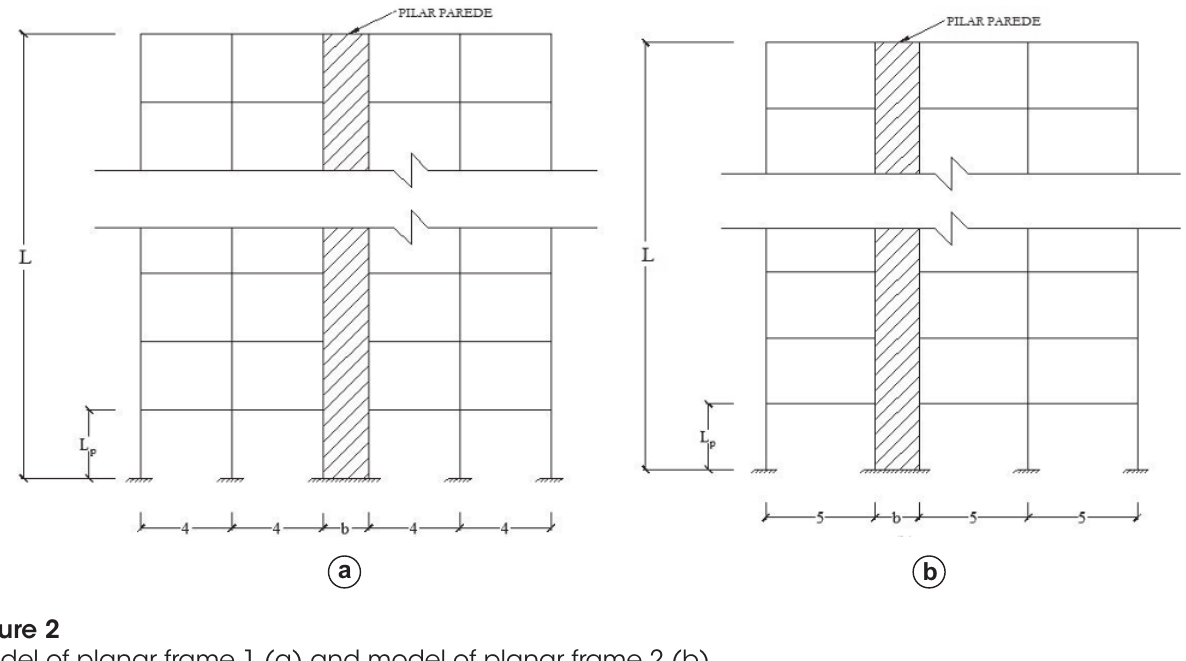
Model of planar frame 1 (a) and model of planar frame 2